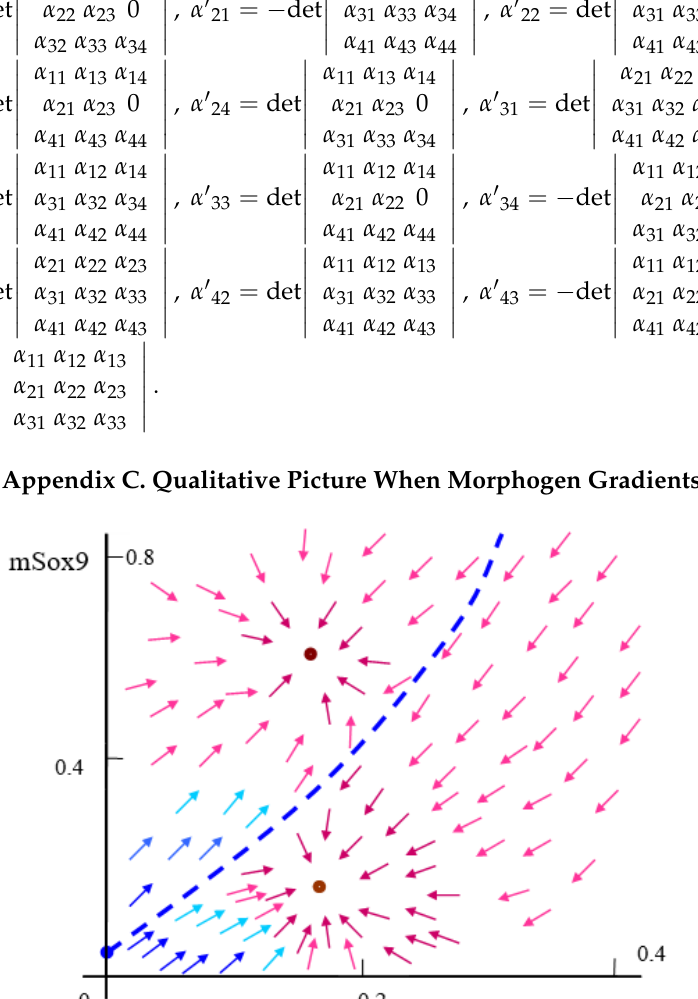
Figure A1. Sketch of the system’s bistability structure in case of I 1 = I 2 = 0. Dashed blue line remarks the boundary of bistability between two stable equilibria (fixed points). Red points and arrows are stable; Blue point and arrows are unstable.